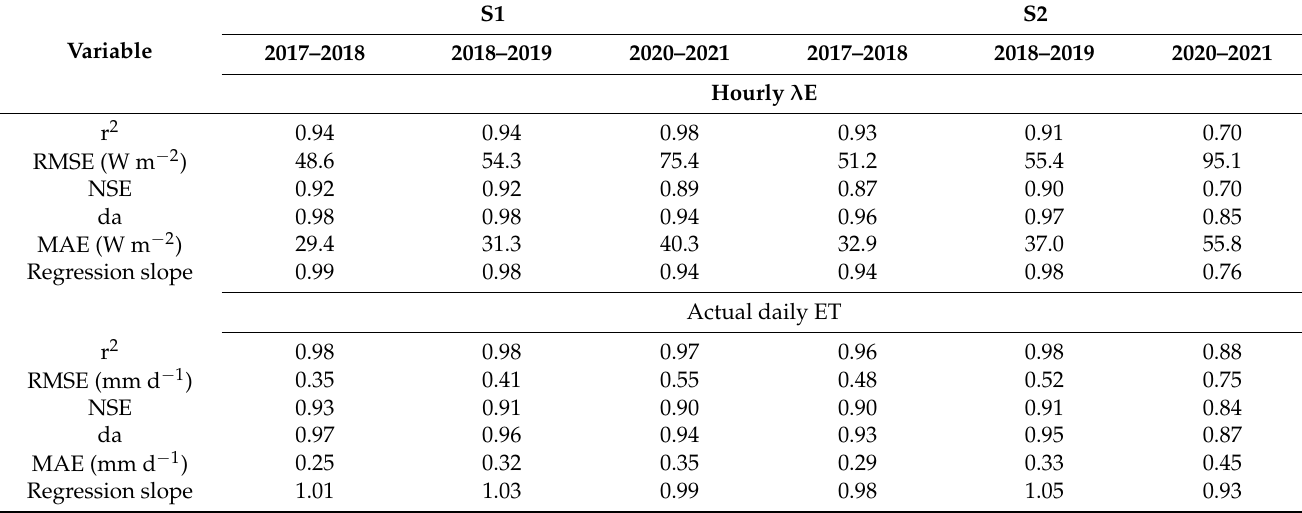
Table 4. Statistical parameters for instantaneous λ E and actual daily ET.